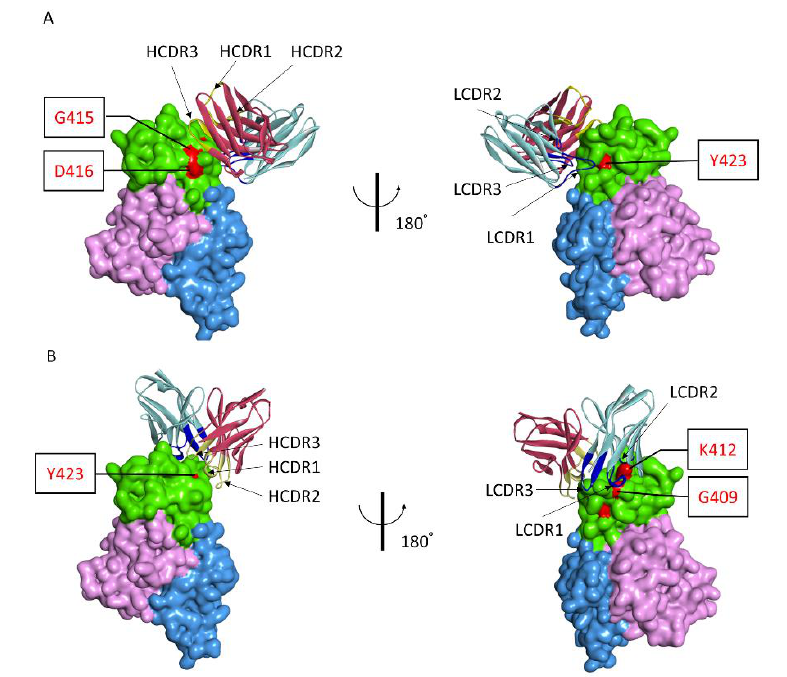
Figure 6. Antigen–antibody molecular docking of two NAbs with RVFV Gn. ( A ) Overall structure of Gn and 1332F11 complex. Domain III of Gn is presented as green, domain I is presented as pink, and domain II is presented as blue. The red regions in domain III represent critical residues for 1332F11. For 1332F11, dark red indicates the heavy-chain, and light-blue represents the light-chain. CDRs in heavy-chain and light-chain are shown in yellow and dark blue, respectively. ( B ) Overall structure of Gn and 1331E4 complex, as presented in ( A